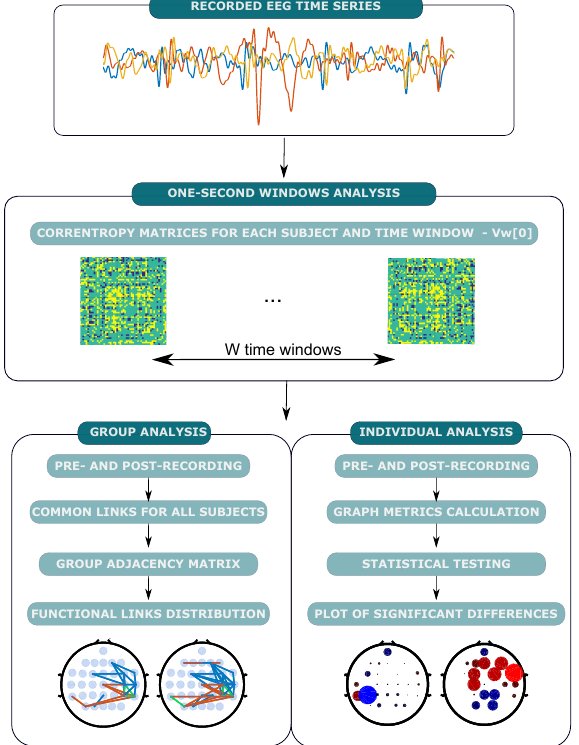
Figure 2. Illustrative diagram of the methodological steps: the recorded EEG time-series are analyzed in one-second windows, with the corresponding correntropy between sensors being computed. Next, subject-specific adjacency matrices are built based on binarization thresholds related to the strength of functional links and to the their persistence across the data recordings. Finally, our analyses encompass two approaches: one, at the group level, aims at determining changes in FC patterns common to all subjects; and the other, at the participant level, has as goal to characterize changes in the graphs’ topology through specific